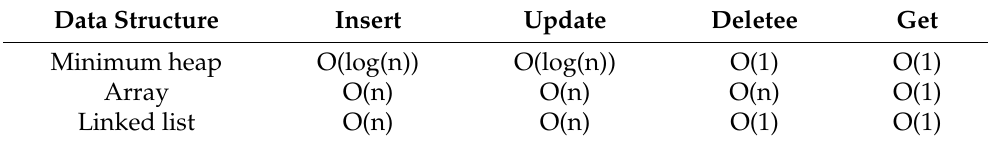
Table 3. Comparison of time complexity of spike queue constructed by three data